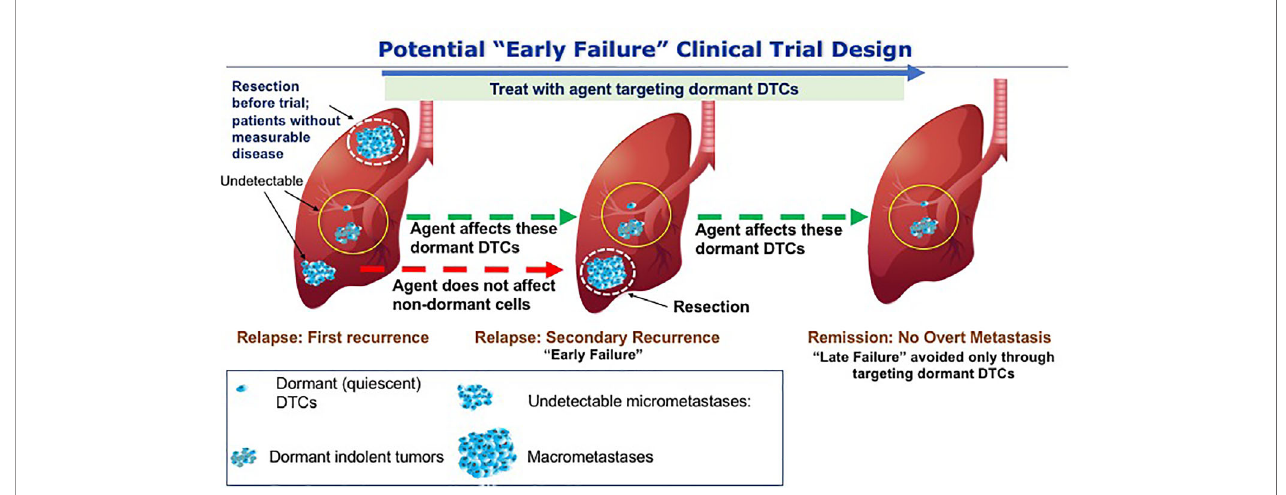
FIGURE 4 | Potential trial to avoid late clinical failure through targeting dormant DTCs. The scenario presented here hypothetically addresses potential drugs that will prevent the outbreak of dormant DTCs in the lungs of OS patients. At the fi rst event of relapse, dormant DTCs that are either quiescent and/or indolent are in the background of proliferating metastases. Upon resection and treatment with the drugs that targets dormant DTCs, cells that are not dormant will not be affected by the treatment and thus may lead to secondary recurrence ( “ early failure) and therefore a clinical bene fi t may only be evident at a later time point, i.e., following the initial “ failure ” to achieve a clinical outcome. By resecting the proliferating metastases and continuing the treatment we may avoid the outbreak of the residing dormant DTCs thus preventing “ late failure ”